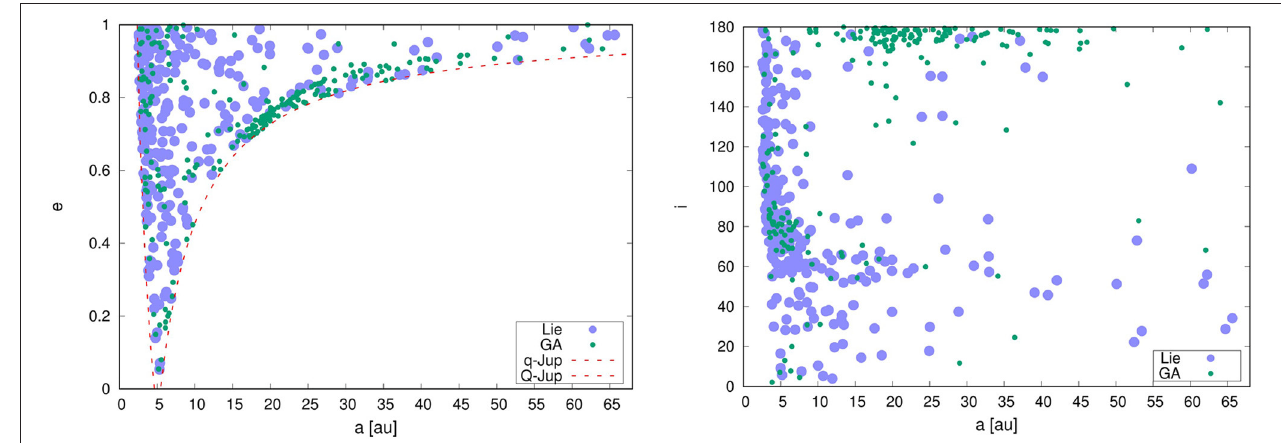
FIGURE 3 | Comparison between measurements of GA and Lie integrations of evoluted orbits for Ganymede close encounters. For the GA, all measurements are taken within Ganymede’s Hill sphere. For the Lie integrations, the measurements are taken as described in the